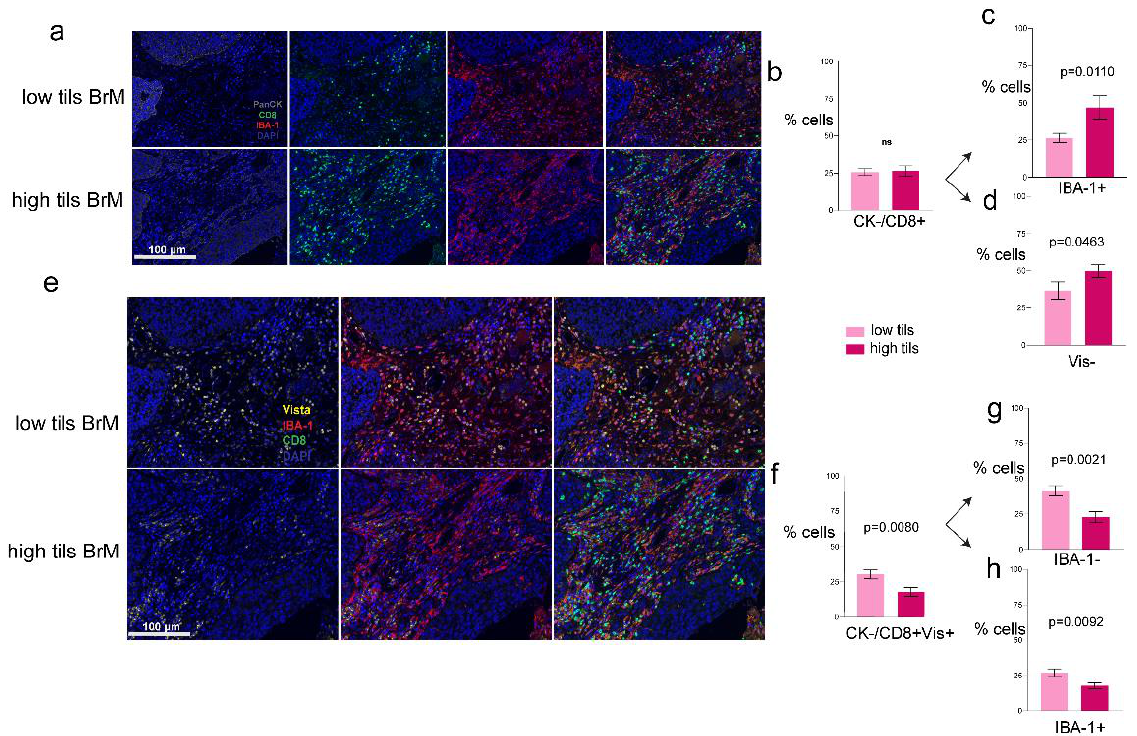
Figure 4. CD8+ T cell populations with arrows indicating the direction of the subsequent gated cell populations within the parent population. ( a ) Representative images of mIF: CK, CD8, and IBA-1; ( b ) CD8+ gated population of cells comparison between the low and high TIL groups; ( c ) bar graphs showing IBA-1+ cells within the CK − /CD8+ parent populations; ( d ) VISTA negative cells within the CK − /CD8+/IBA-1+ cells; ( e ) representative images of mIF: CD8, VISTA and IBA-1; ( f ) CK − /CD8+ gated parent population with VISTA expression; ( g ) far graphs showing IBA-1- cells within the CK − /CD8+Vis+ parent populations; ( h ) IBA-1+ cells within the same parent populations.